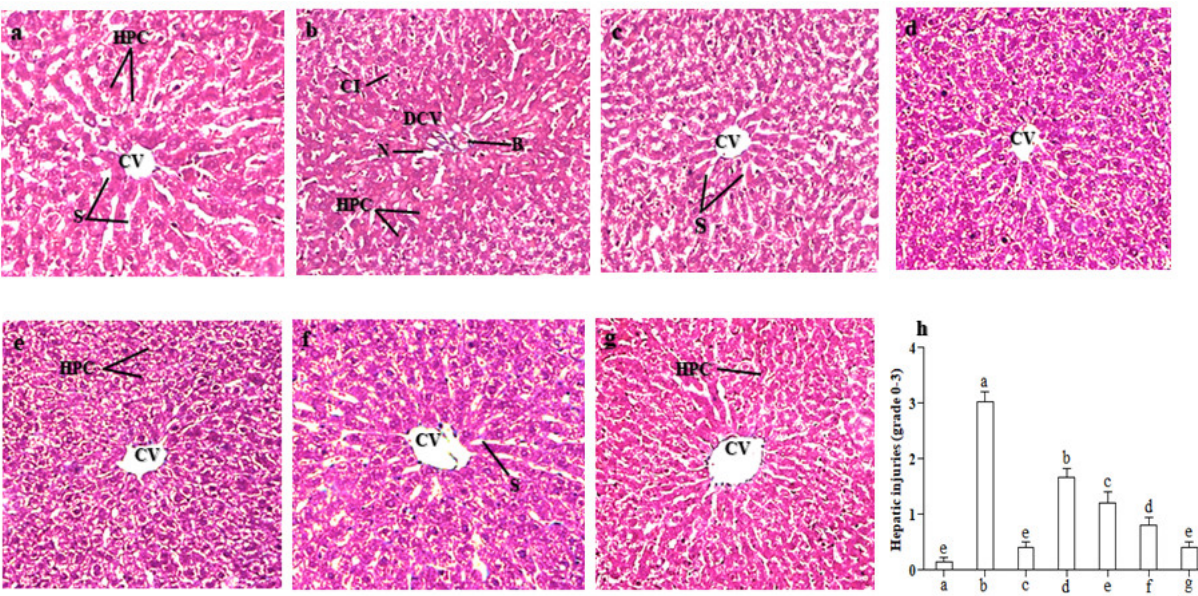
Figure 4. Protective potential of LCM on liver histopathology of rats (40 × magnification with hematoxylin–eosin stain). ( a ) Control group, ( b ) CCl 4 (1 mL/kg bw), ( c ) CCl 4 + silymarin (200 mg/kg), ( d ) CCl 4 + LCM (200 mg/kg), ( e ) CCl 4 + LCM (400 mg/kg), ( f ) LCM (200 mg/kg), ( g ) LCM (400 mg/kg), ( h ) hepatic injuries ranging from 0 to 3, bars not sharing identical letters are significantly different at p < 0.05. CV; central vein. HPC; hepatocytes. DCV; damaged central vein. N; necrosis. B; ballooning of hepatocytes. LCM; Linum corymbulosum methanol